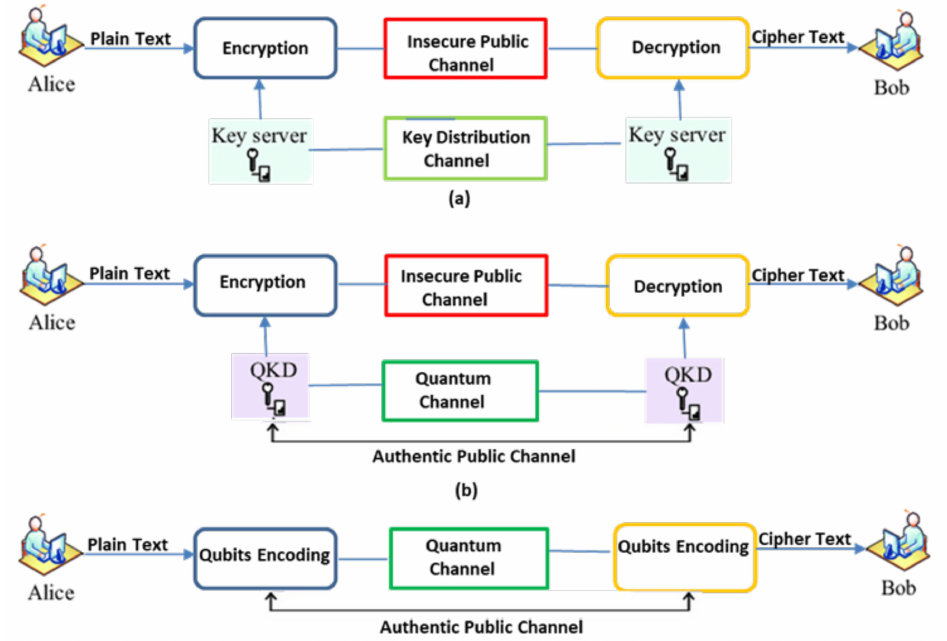
Figure 3. Traditional and Conventional QKD in Cryptographic Representation.